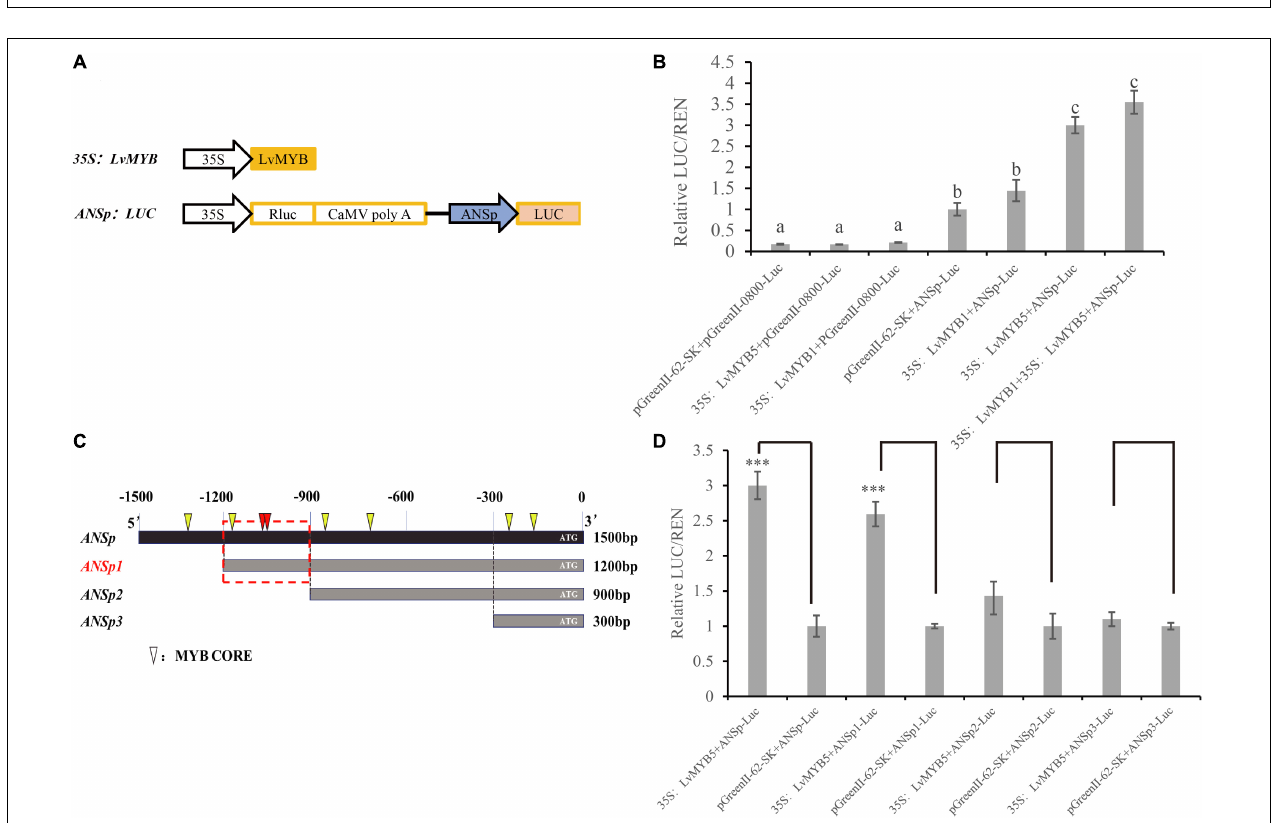
FIGURE 7 | Activation of the ANS promoter by MYB TFs in lily petals. (A) Schematic diagrams showing the vector constructs. (B) Activation of ANSp by transcription factors was verified using the dual luciferase assay. Different letters indicate statistically significant differences between the samples. (C) ANSp fragments used to identify the active MYB TF binding sites. Triangles: MYB CORE. Red triangles: overlapping MYB CORE. Red boxes: possible binding regions. (D) Activation of promoter ANSp fragments by the LvMYB5 TF in lily petals. Data are means ( ± SD) of three biological replicates per construct ( ∗∗∗ p ≤